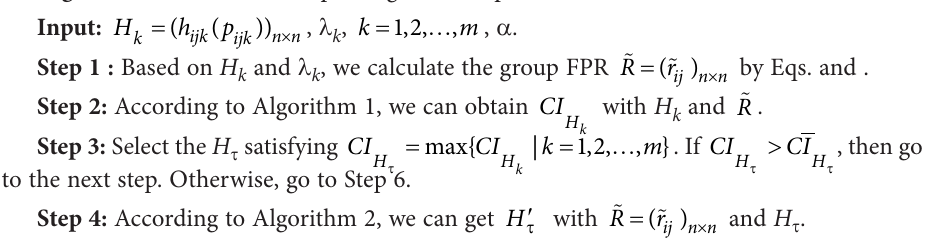
Algorithm 3. Consensus improving for multiple